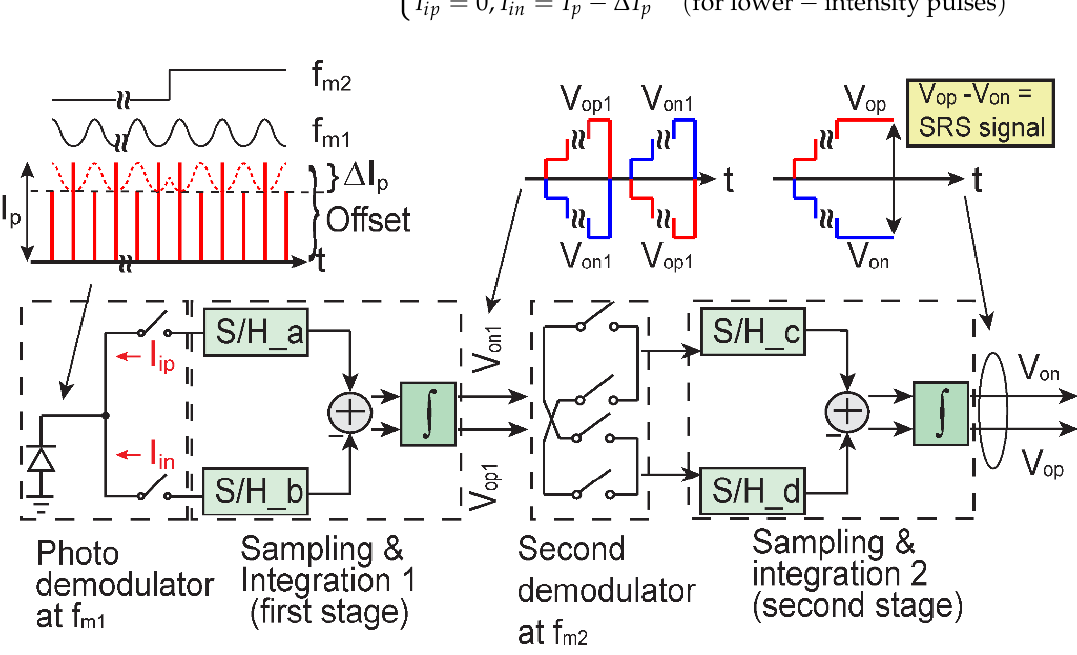
Figure 3. Circuit block diagram for the SRS signal extraction with in ‐ pixel double ‐ modulation.